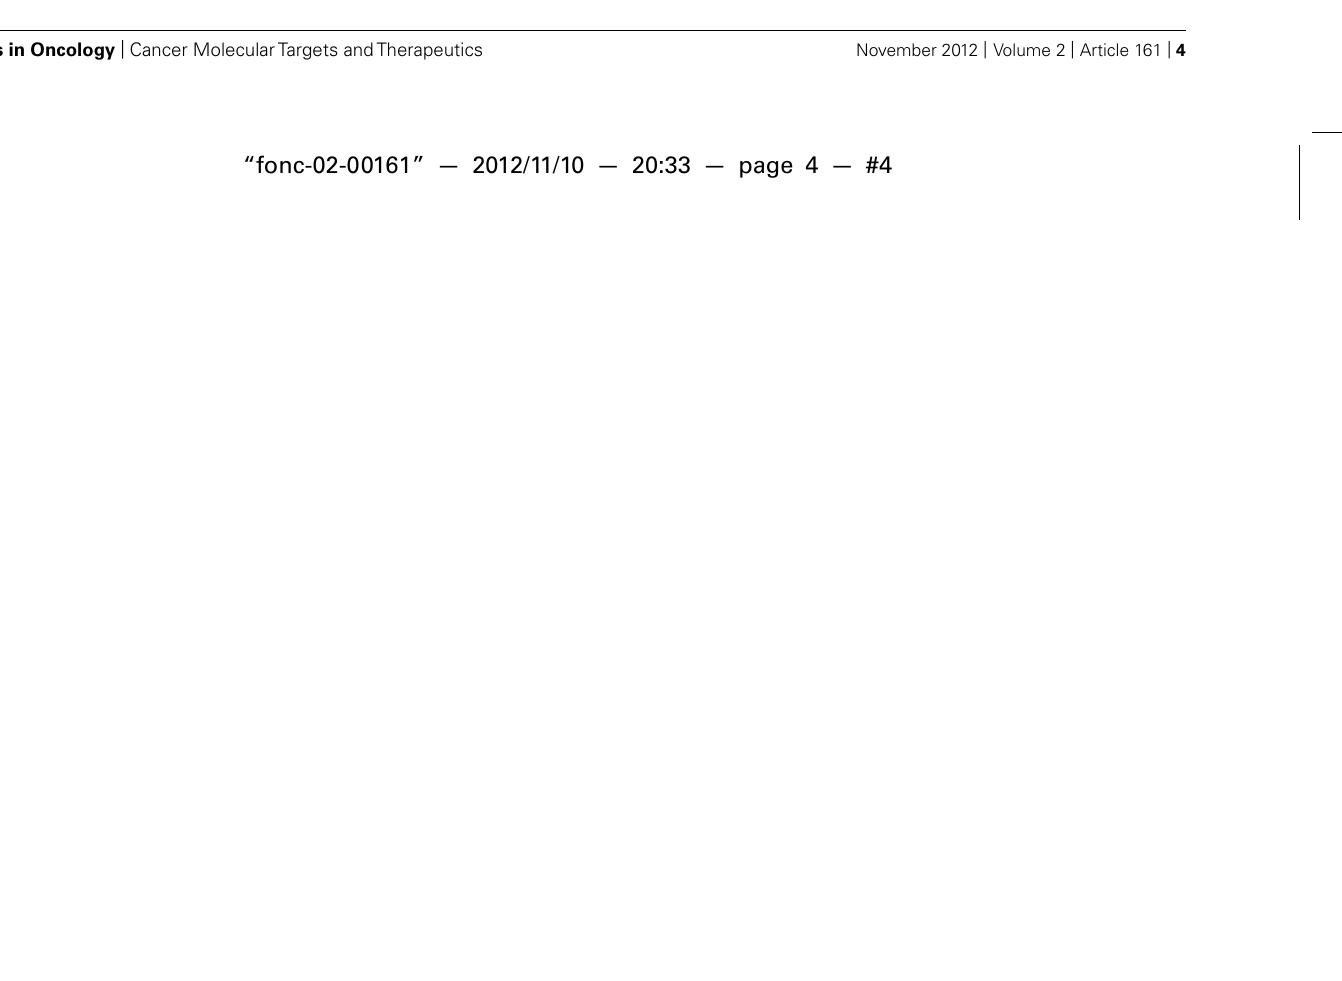
not affected at curcumin concentrations below 10 μ M up to 72 h ( n = 25).The asterisk symbol “*” denotes significant difference ( p < 0.05) as compared to control